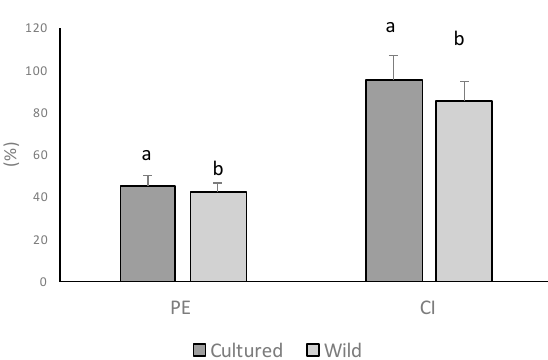
Figure 1. Mean values of three replicates ± standard deviation. Percentage of edibility (PE) and condition index (CI) of cultured and wild Flexopecten glaber . Different letters indicate significant differences ( p < 0.05).